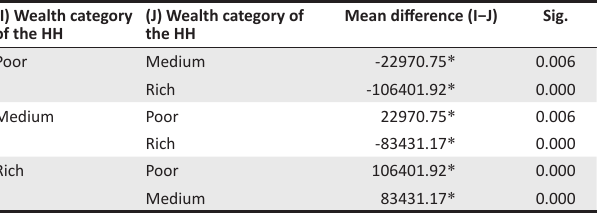
TABLE 4: Mean income comparisons using the Least Significance Difference Test amongst wealth category of household heads. (I) Wealth category of the HH